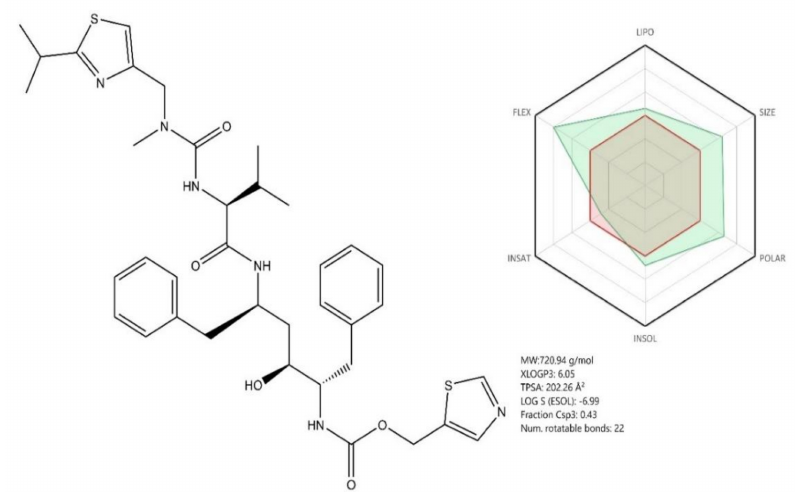
Figure 9. Chemical structure of Ritonavir; ADME profile was achieved using the free web tool SwissADME; the red highlighted area represents the suitable physicochemical space for oral bioavailability covering value intervals for the following: LIPO (lipophility): − 0.7 < XLOGP3 < + 5.0, SIZE: 150 g / mol < MV < 500 g / mol, POLAR (polarity): 20Å 2 < TPSA < 130Å 2 , INSOLU (insolubility): 0 < Log S (ESOL) < 6, INSATU (insaturation): 0.25 < Fraction Csp3 < 1, FLEX (flexibility): 0 < Num. rotatable bonds < 9, whereas the overlapped green highlighted area shows the calculated ADME profile for the molecule